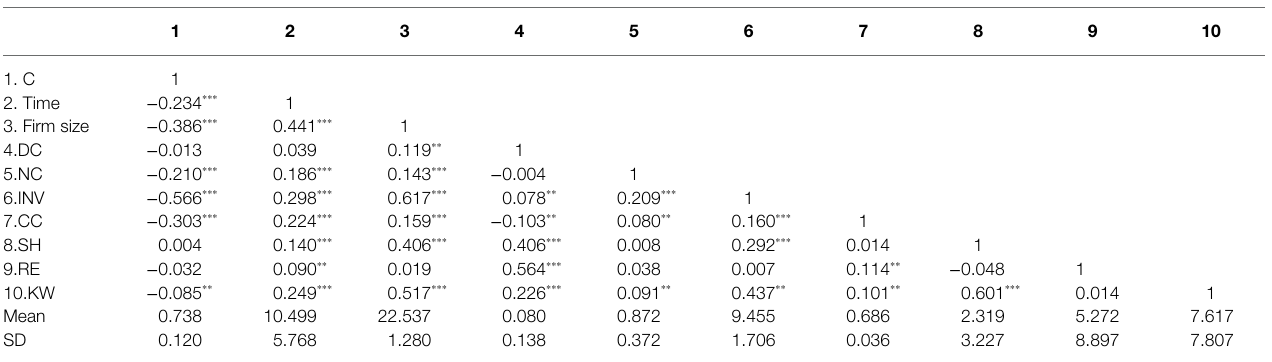
TABLE 2 | Descriptive statistics and correlation